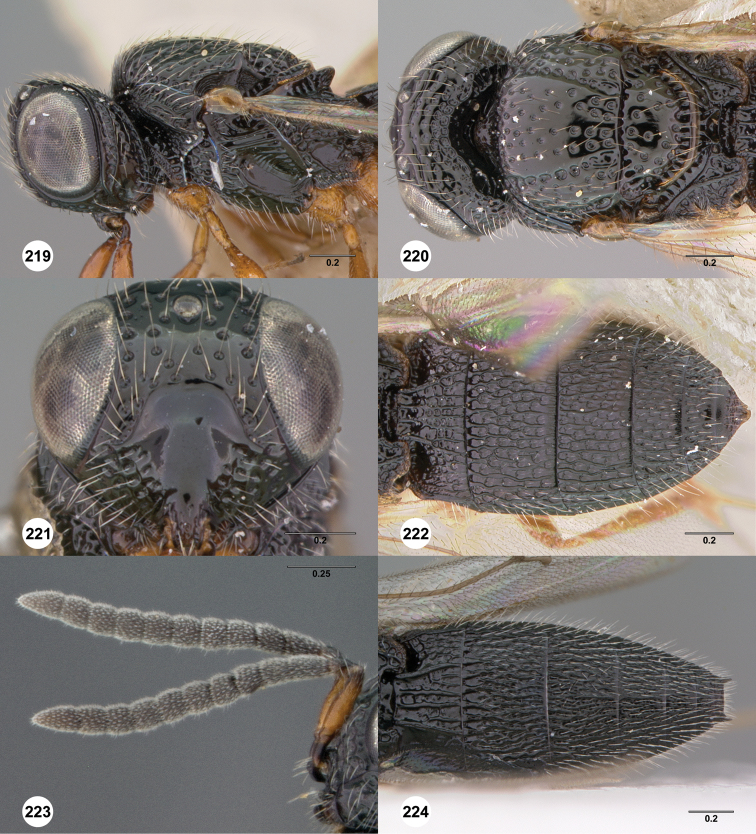
Oxyscelio nitoris sp. n., female (OSUC 359541) 219 Head and mesosoma, lateral view 220 Head and mesosoma, dorsal view 221 Head, anterior view 222 Metasoma, dorsal view. Paratype male (QM Reg. No. T35136) 223 Antenna 224 Metasoma, dorsal view. Morphbank70